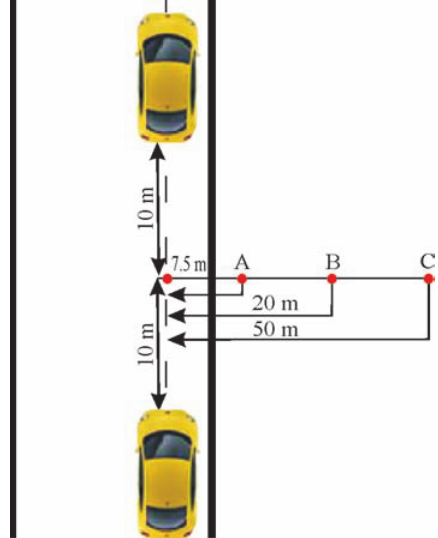
Fig. 1. Points selected to measure noise level produced by a moving